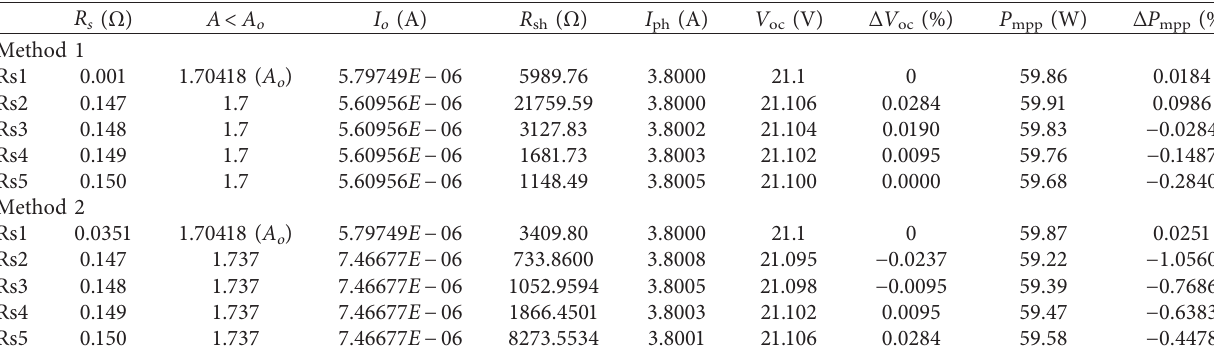
Table 5: Extracted parameters and data from simulations for Solarex MSX60.